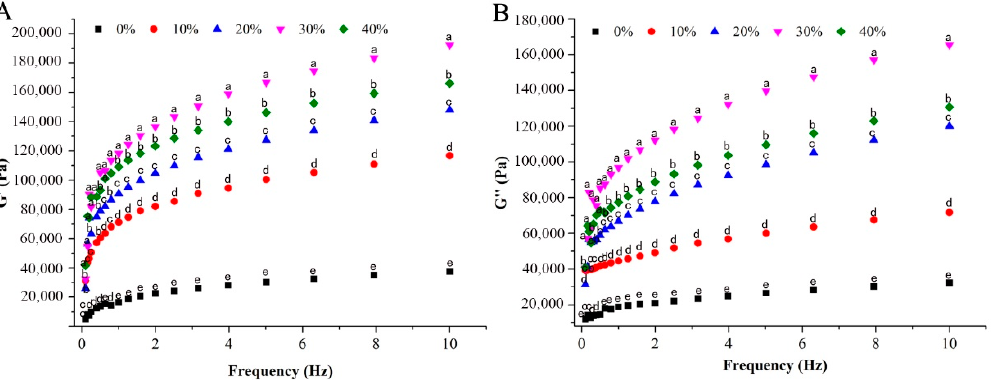
Figure 1. E ff ects of wheat flour supplemented with di ff erent levels of Chinese yam powder (CYP) on Figure 1. Effects of wheat flour supplemented with different levels of Chinese yam powder (CYP) on rheological properties. Storage moduli (G’) ( A ) and Loss moduli (G”) ( B ). The values of di ff erent letters rheological properties. Storage moduli (G’) ( A ) and Loss moduli (G’’) ( B ). The values of different represent the significantly di ff erent ( p < 0.05) of wheat flour supplemented with di ff erent levels of CYP letters represent the significantly different ( p < 0.05) of wheat flour supplemented with different levels at the same of CYP at the same frequencies.